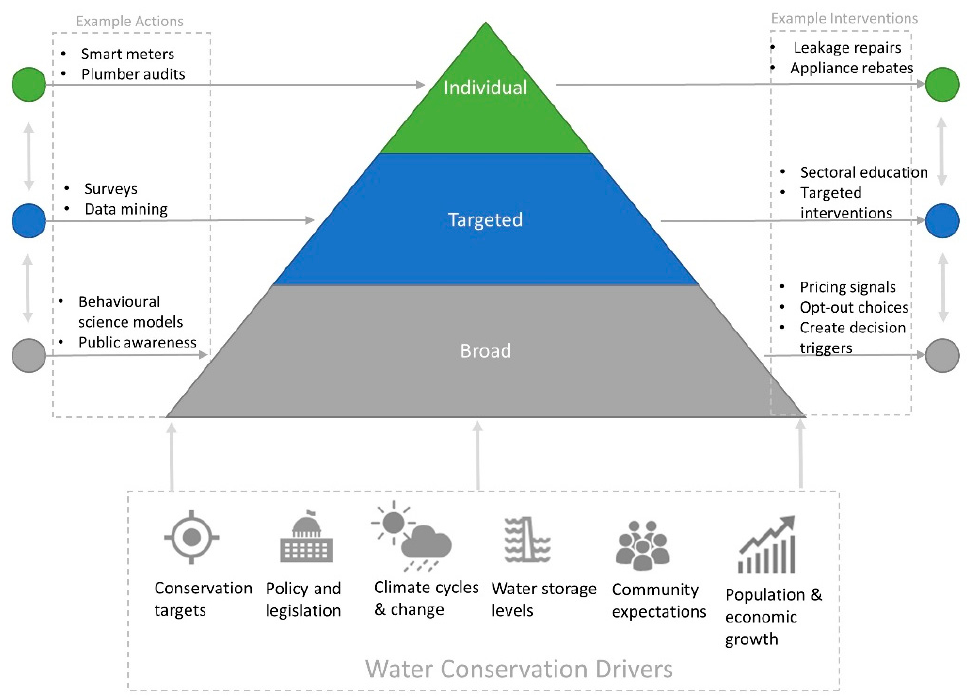
Figure 2. Water conservation drivers and levels of intervention